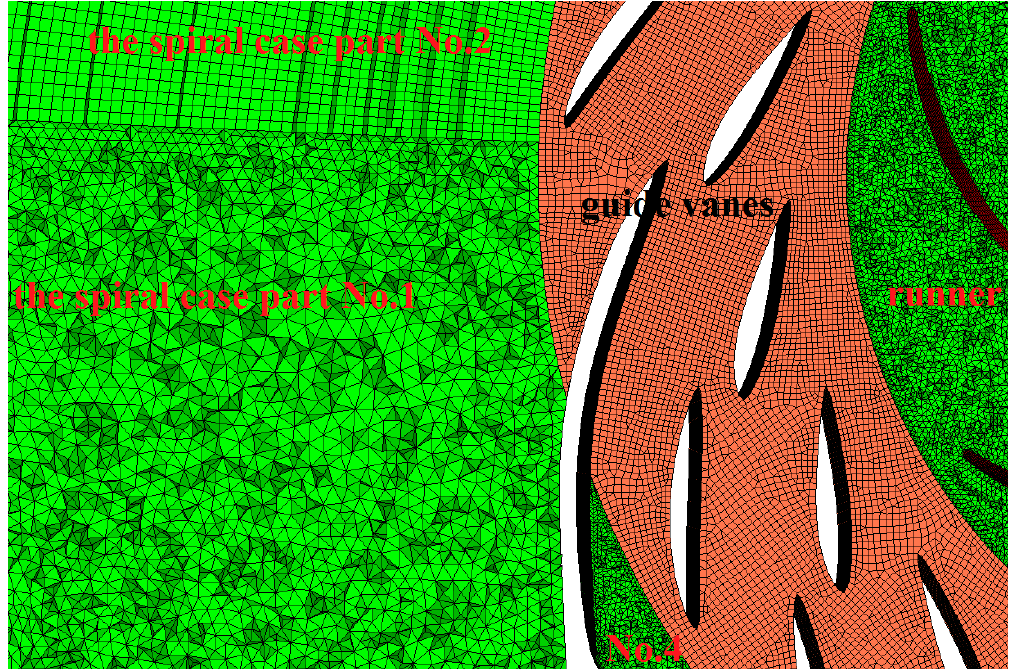
Figure 2. Grids in centerplane of guide vanes.